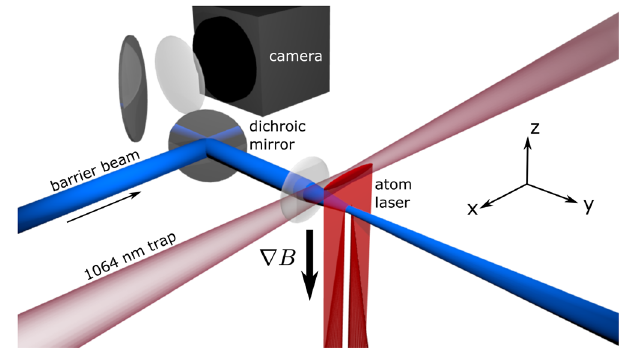
Fig. 2 Experimental setup. Atoms from a 87 Rb BEC (red) are coherently out-coupled from a dipole trap (maroon) to form an atom laser. The atoms are accelerated downward by the combined action of gravity and an external magnetic gradient. The accelerated fl ow encounters a potential created by an additional laser (blue). In this depiction, the potential is repulsive to the atoms. The fl ow pro fi le is imaged by a CCD camera using